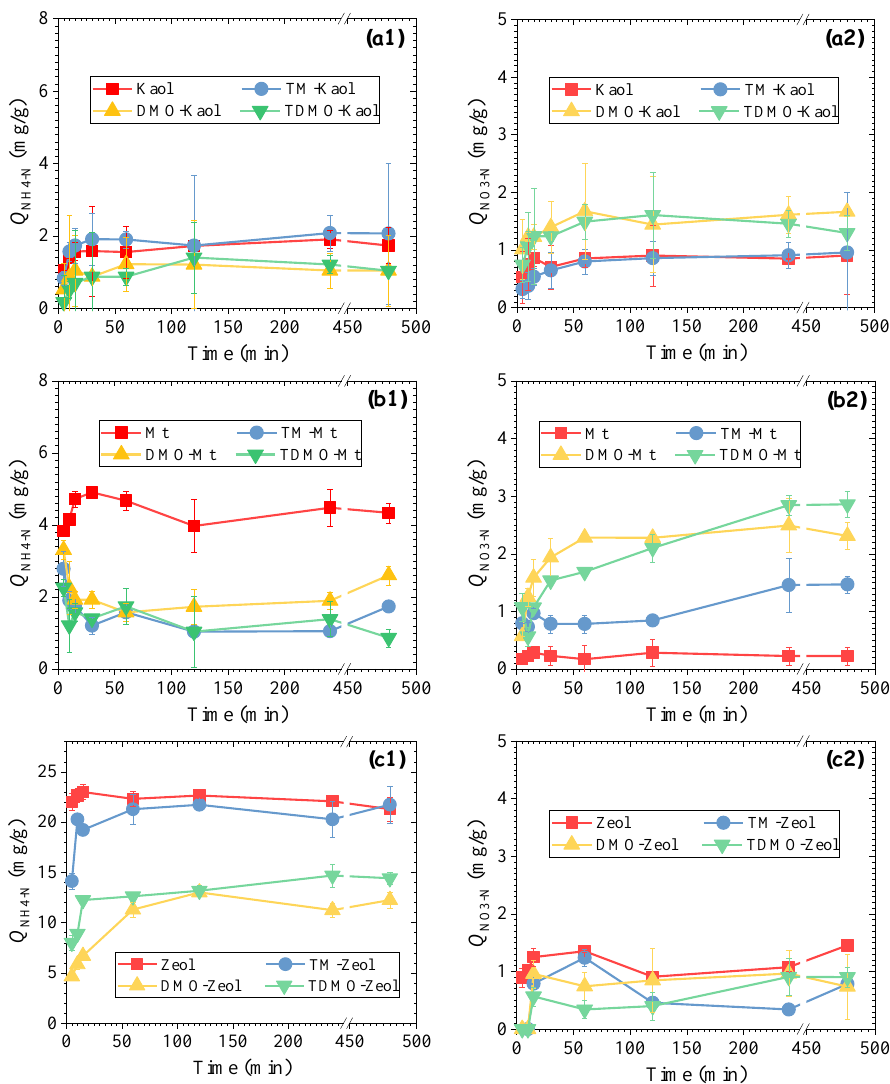
Figure 5. Influence of contacting time on the adsorption of NH 4+ -N and NO 3 − -N on the grafted ( a1 , a2 ) Kaol, ( b1 , b2 ) Mt, and ( c1 , c2 )